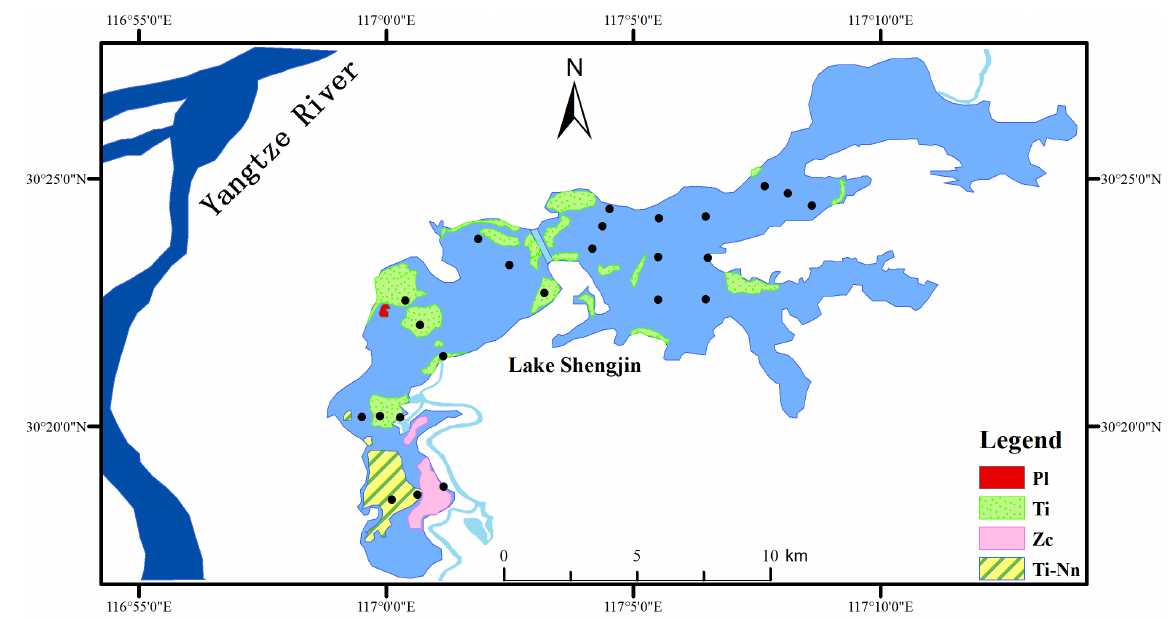
Figure 2. Distribution of dominant associations of main aquatic plants in summer. The following abbreviations used in the diagram are: Pl: Polygonum lapathifolium , Ti: Trapa incisa , Zc: Zizania caduuciflora , and Ti-Nn: Trapa incisa - Nelumbo nucifera .